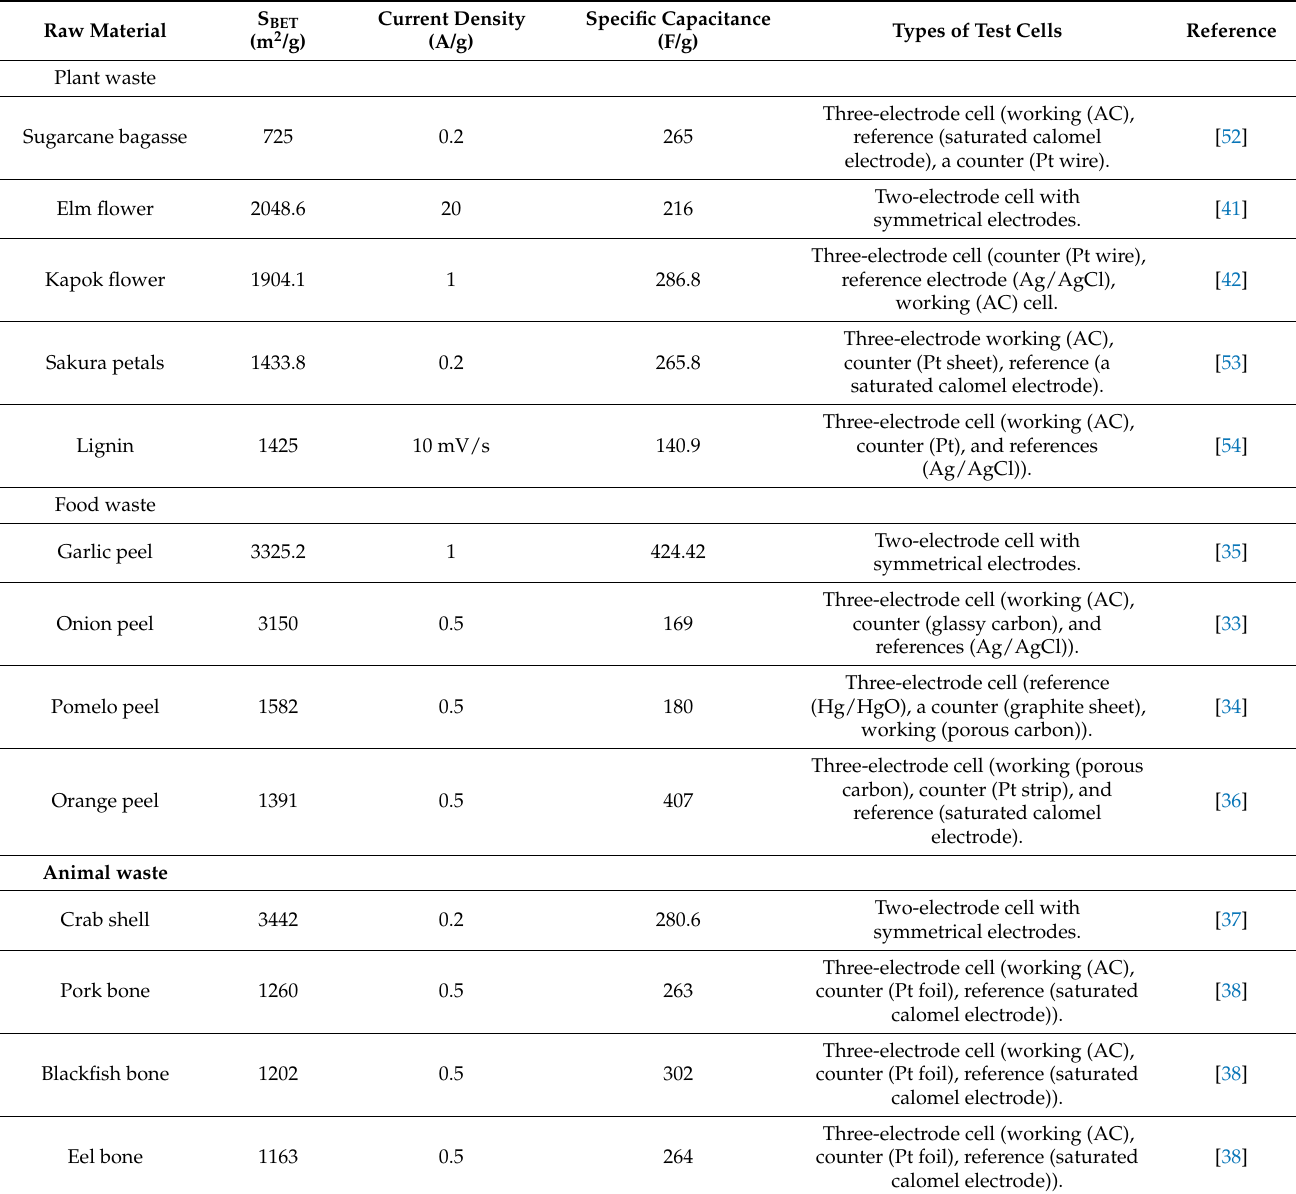
Table 2 lists characteristics of some carbon-based supercapacitor electrodes from biowaste. Table 2. Biowaste-derived activated carbon and AC-based electrodes for